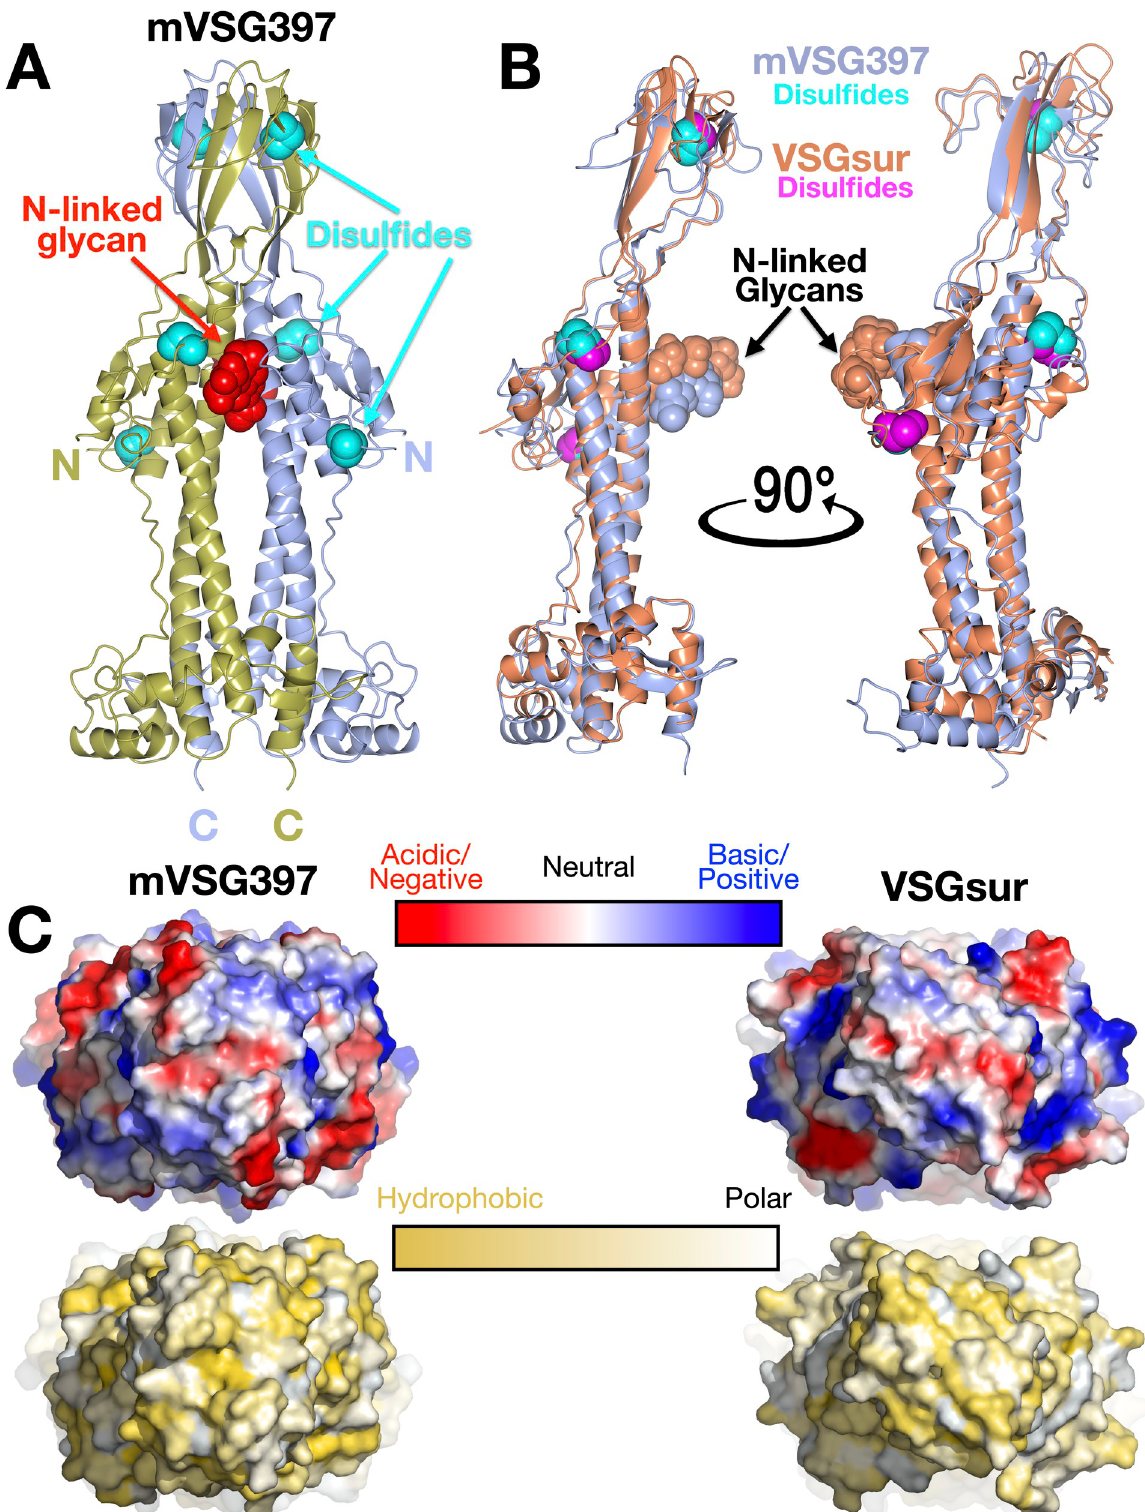
Fig 2. Crystal structure of mVSG397. (A) Ribbon diagram of the (crystallographic) dimer of mVSG397, the individual monomers colored gold and light blue. The N-linked glycans are displayed as red space-filling atoms and disulfide bonds are shown in cyan. ‘N’ and ‘C’ indicate the